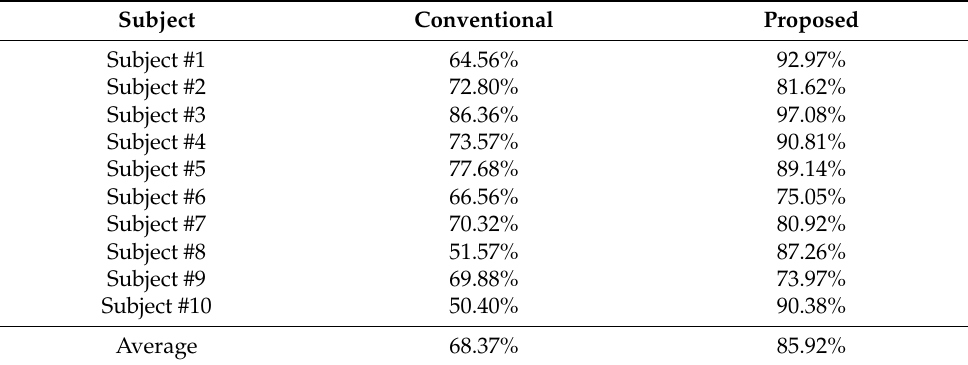
Figure 9. Respiration extraction results for the case shown in Figure 5b. ( a ) Subject #1, ( b ) Subject #2, ( c ) Subject #3, ( d ) Subject #4, ( e ) Subject #5, ( f ) Subject #6, ( g ) Subject #7, ( h ) Subject #8, ( i ) Subject #9, and ( j ) Subject #10. Table 3. Comparison of respiratory rate accuracy for the case shown in Figure